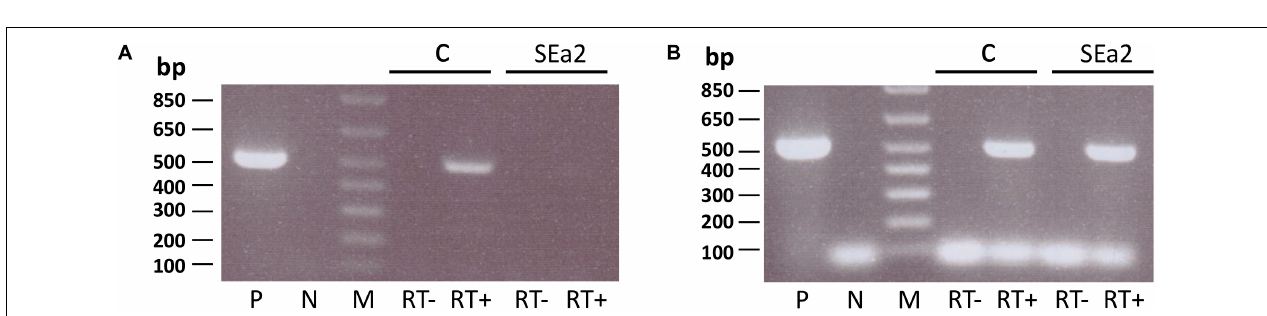
FIGURE 6 | Analysis of pre-rRNA maturation in cells depleted of the RNA splicing endonuclease. (A) Schematic representation of the H. volcanii rDNA operon. One of the two rDNA operons (operon A: HVO_3038-HVO_3042 and flanking regions) present in H. volcanii and characterized by an additional tRNA Cys gene at its 3 (cid:48) end is schematically depicted. The inverted repeats flanking the mature 16S/23S rRNAs establish double stranded RNA regions containing bulge-helix-bulge (BHB) motifs, putative substrates for the splicing endonuclease (SE, scissors). Primers used for quantitative RT-PCR analysis of total 16/23S rRNAs (shown in orange), pre-circular 16S/23S rRNAs (post-BHB cleavage pre-rRNA species, blue) and 5 (cid:48) pre-16S/23S rRNAs containing regions upstream of the respective 5 (cid:48) bulge (pre-BHB cleavage pre-rRNA species, green) are indicated (green arrows). (B) Pre-rRNA maturation profile of cells depleted of SE analyzed by qRT-PCR.